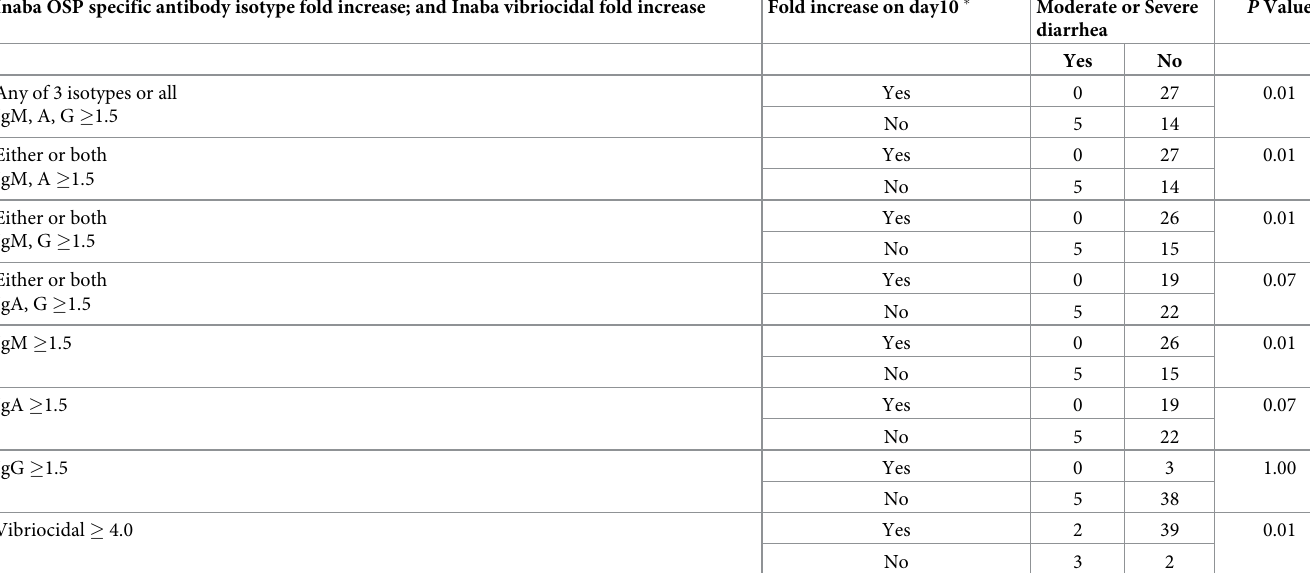
Table 3. Serum Inaba OSP-specific antibody isotype fold increase ( (cid:21) 1.5) and Inaba-specific vibriocidal fold increase ( (cid:21) 4) on day 10 following vaccination as a pre- dictor of protection against development of moderate or severe diarrhea following subsequent challenge. Inaba OSP specific antibody isotype fold increase; and Inaba vibriocidal fold increase